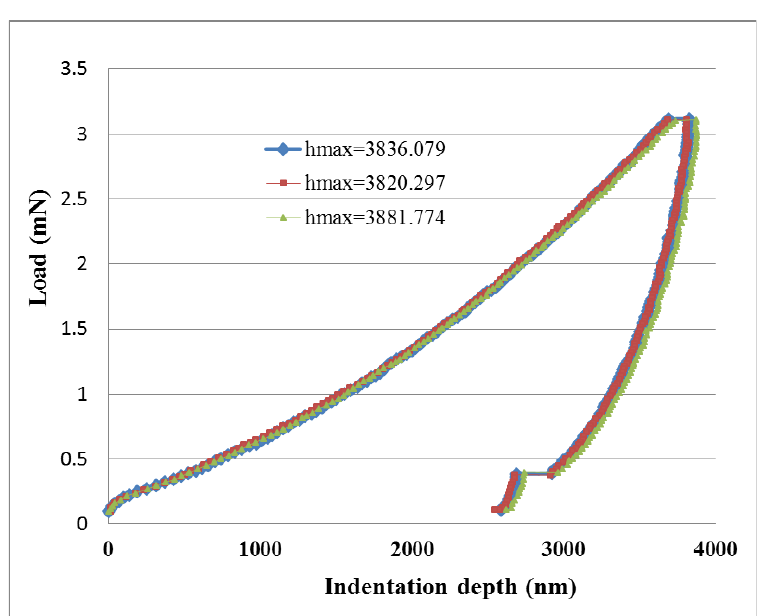
Figure 9. Load vs. indentation depth for the buckypaper made of high aspect ratio MWCNTs.